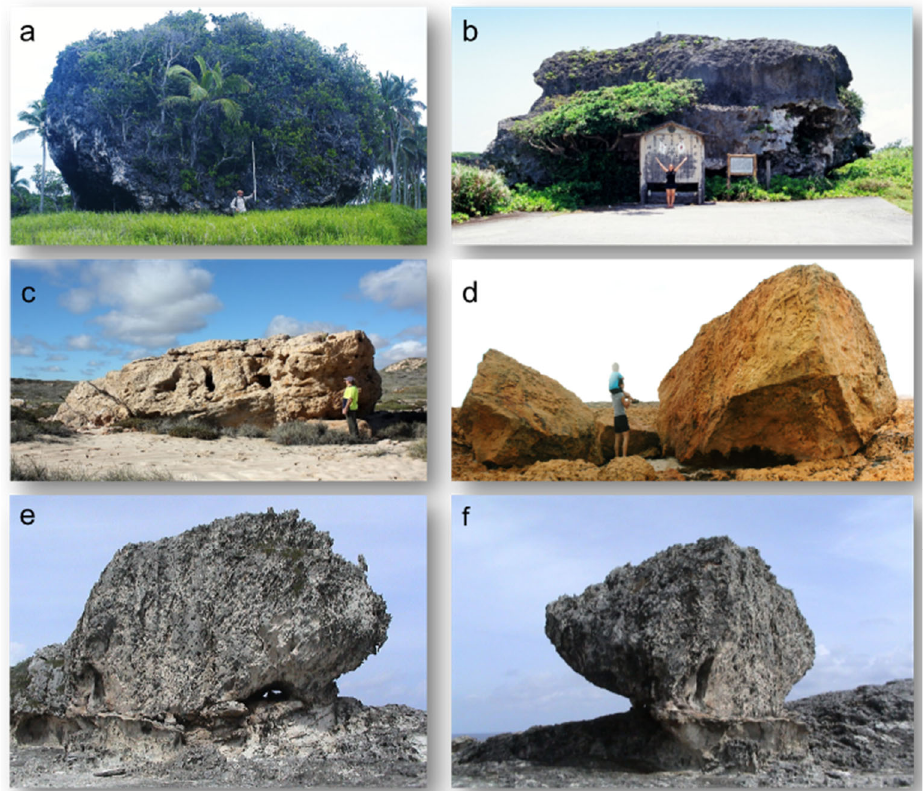
Figure 1. Examples of exceptional large individual boulders deposited by tsunamis in the younger Holocene ( a – d ) and the Eemian period ( e , f ): ( a ) Tonga, about 2000 tons (Frohlich et al., 2009); ( b ) Tsunami block (“Tsunami-ishi“) from Japan, >1000 tons; ( c ) Western Australia, about 700 tons (Playford, 2014); ( d ) Quobba, Western Australia, about 90 tons, dated 1060 cal BP; ( e ) “Bull“, Eleuthera (Bahamas), about 950 tons; ( f ) “Cow“, Eleuthera (Bahamas), about 440 tons.